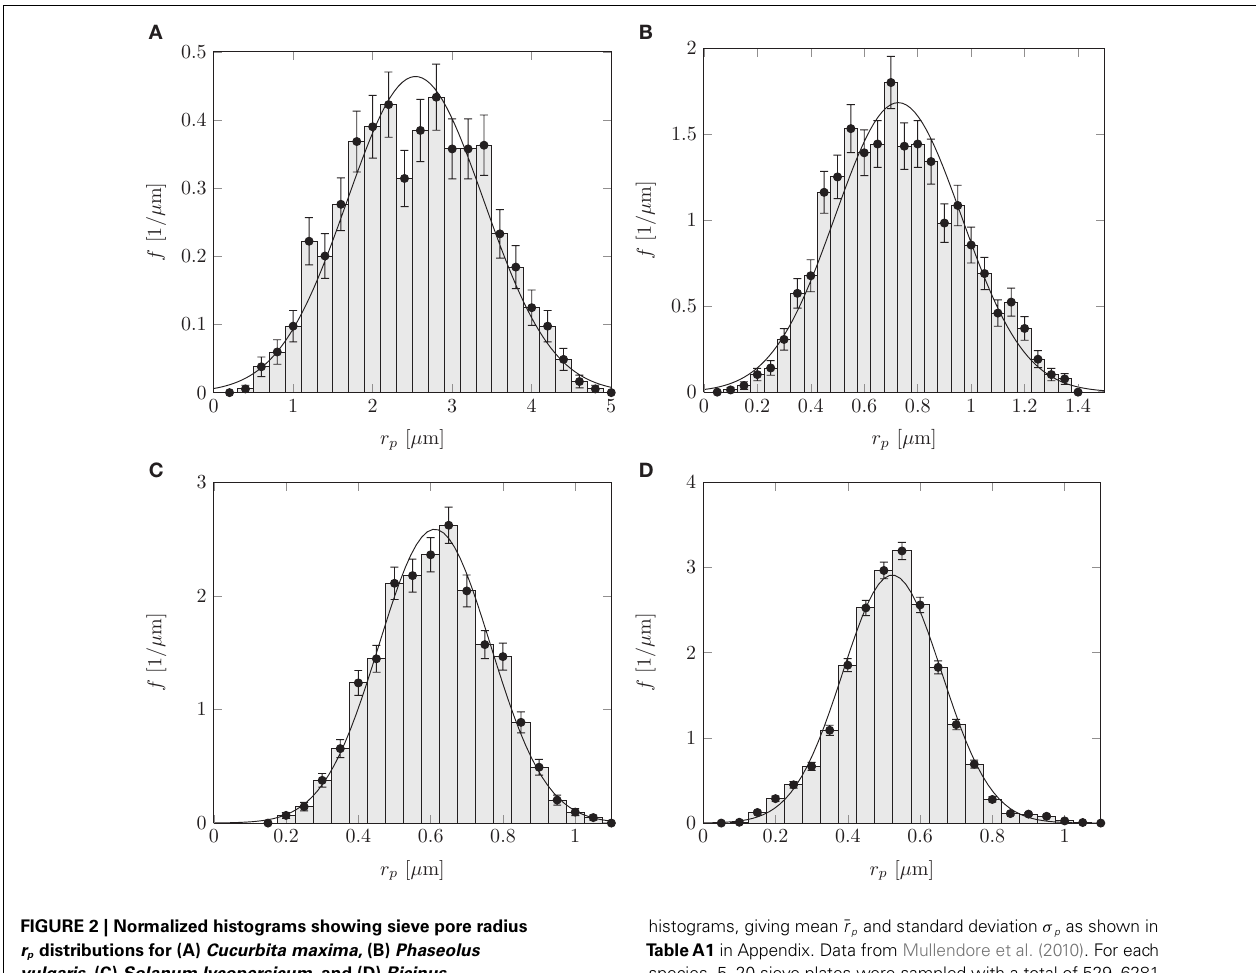
histograms, giving mean ¯ r p and standard deviation σ p as shown in TableA1 in Appendix. Data from Mullendore et al. (2010). For